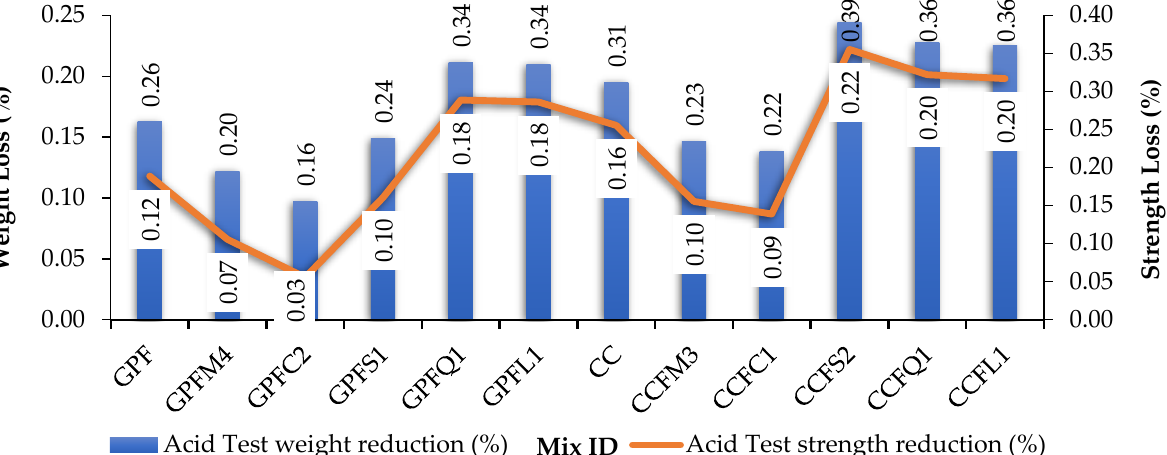
Figure 10. Acid test results of GPC and CC.